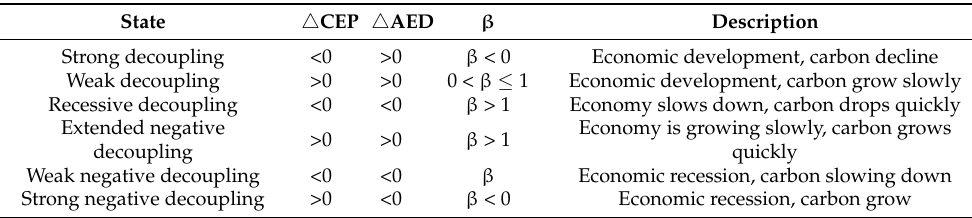
Table 2. Judgment standard of decoupling model between the agricultural gross domestic product (AED) and carbon emissions of the planting industry